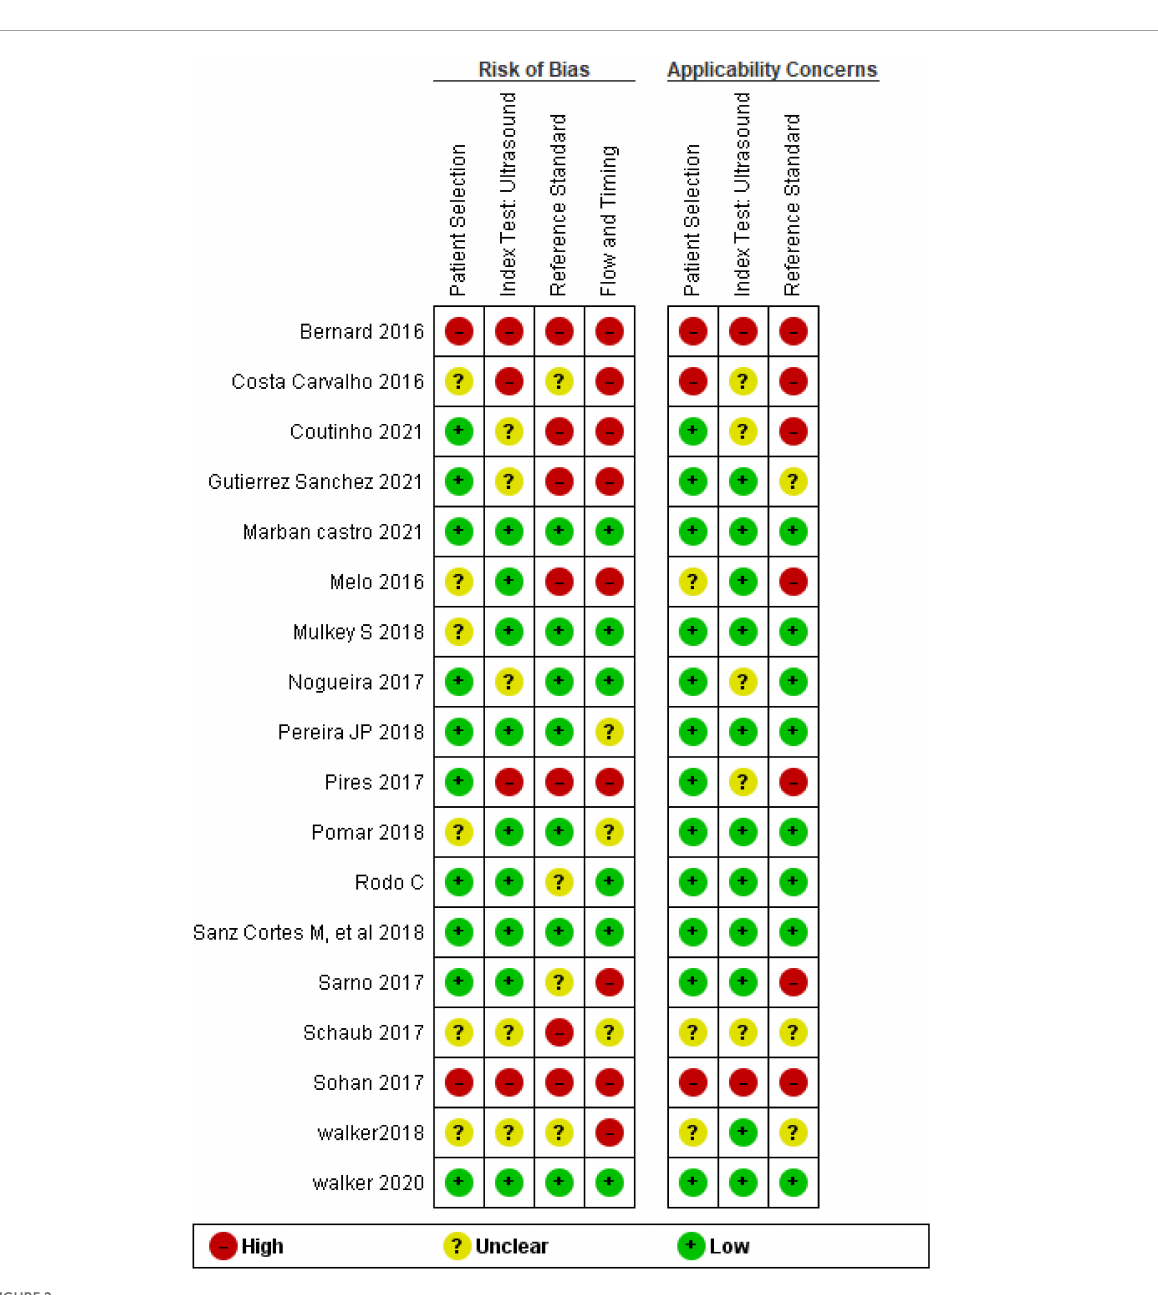
FIGURE2 QUADAS 2 risk of bias and applicability of